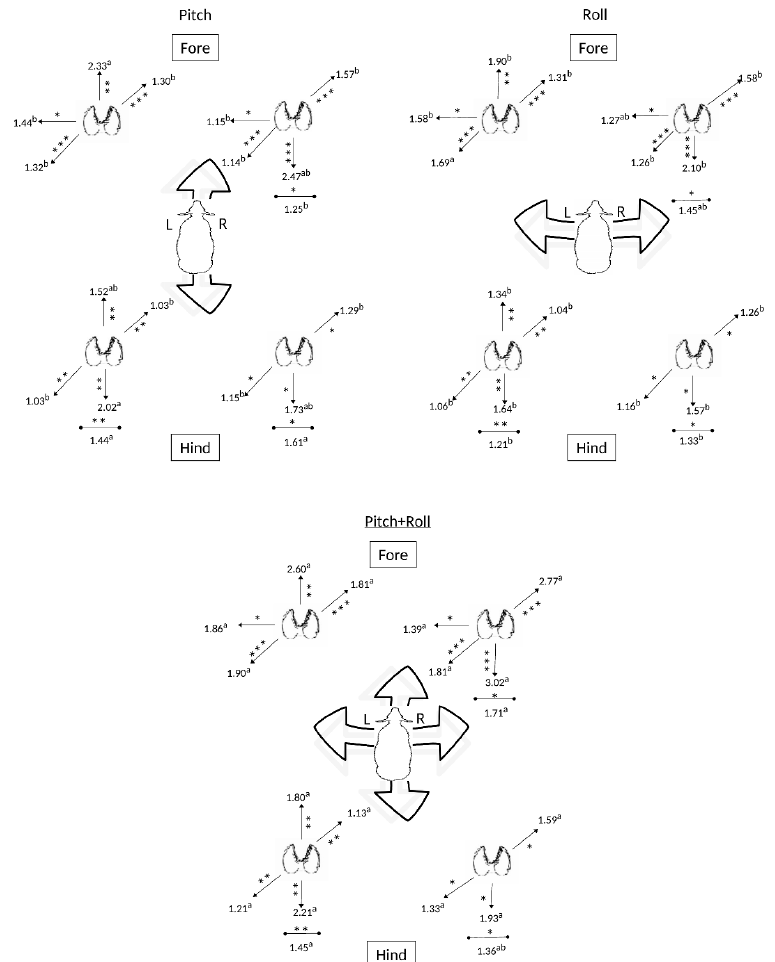
Figure 3. Effects of the type of movement (roll, pitch or the two combined) of the floor on stepping responses (steps/20 min) of the four limbs of sheep ( n = 6). Directions for which significant differences in stepping frequency are presented (* p < 0.05; ** p < 0.02; *** p < 0.001). Different superscript letters (a,b,c,d,e,f) denote significantly different responses ( p < 0.05) observed for each individual limb.